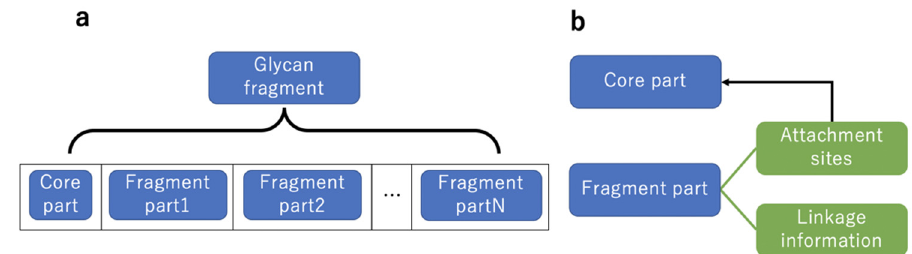
Figure 8. Relationships of data structures for glycan fragments. ( a ) A glycan fragment is treated as an array of data structures for core and fragment parts. The data structure for each part is defined as Glycan class in SugarSketcher. ( b ) Each Fragment part contains Attachment sites for the Core part and Linkage information.